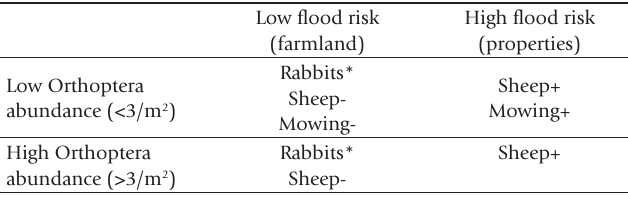
Table 5. Matrix to enable appropriate grazing and mowing regimes to be chosen in relation to Orthoptera abundance and maintain- ing flood defense